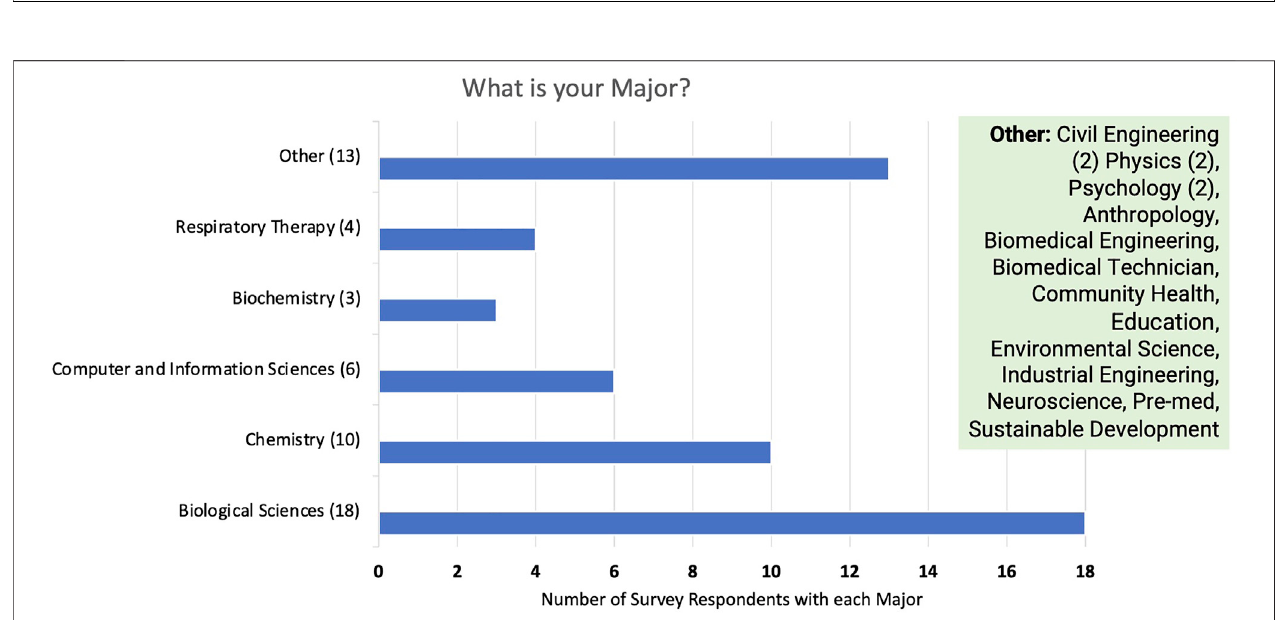
FIGURE 3 | Academic major of students in the